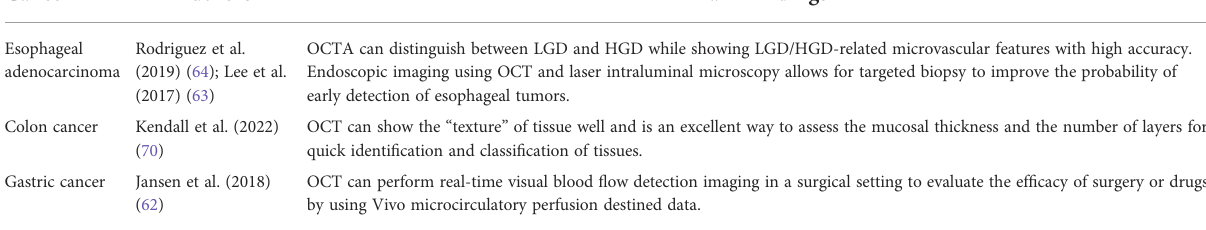
TABLE 2 The imaging capabilities of OCT in gastrointestinal tumors.